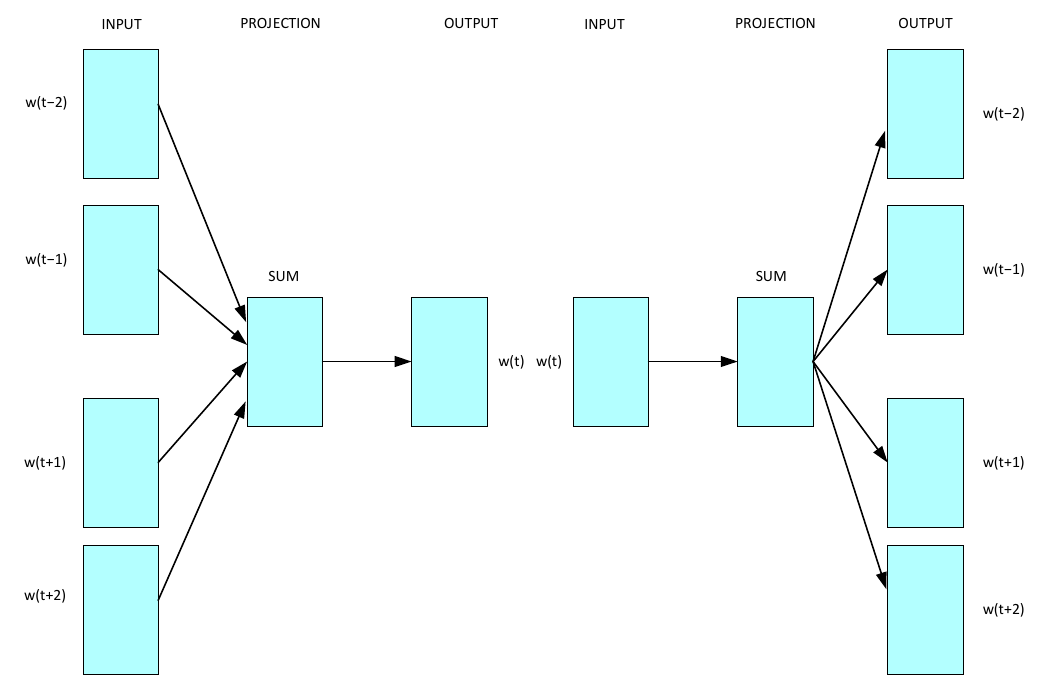
Figure 1. CBOW model ( left ) and skip-gram model ( right ).